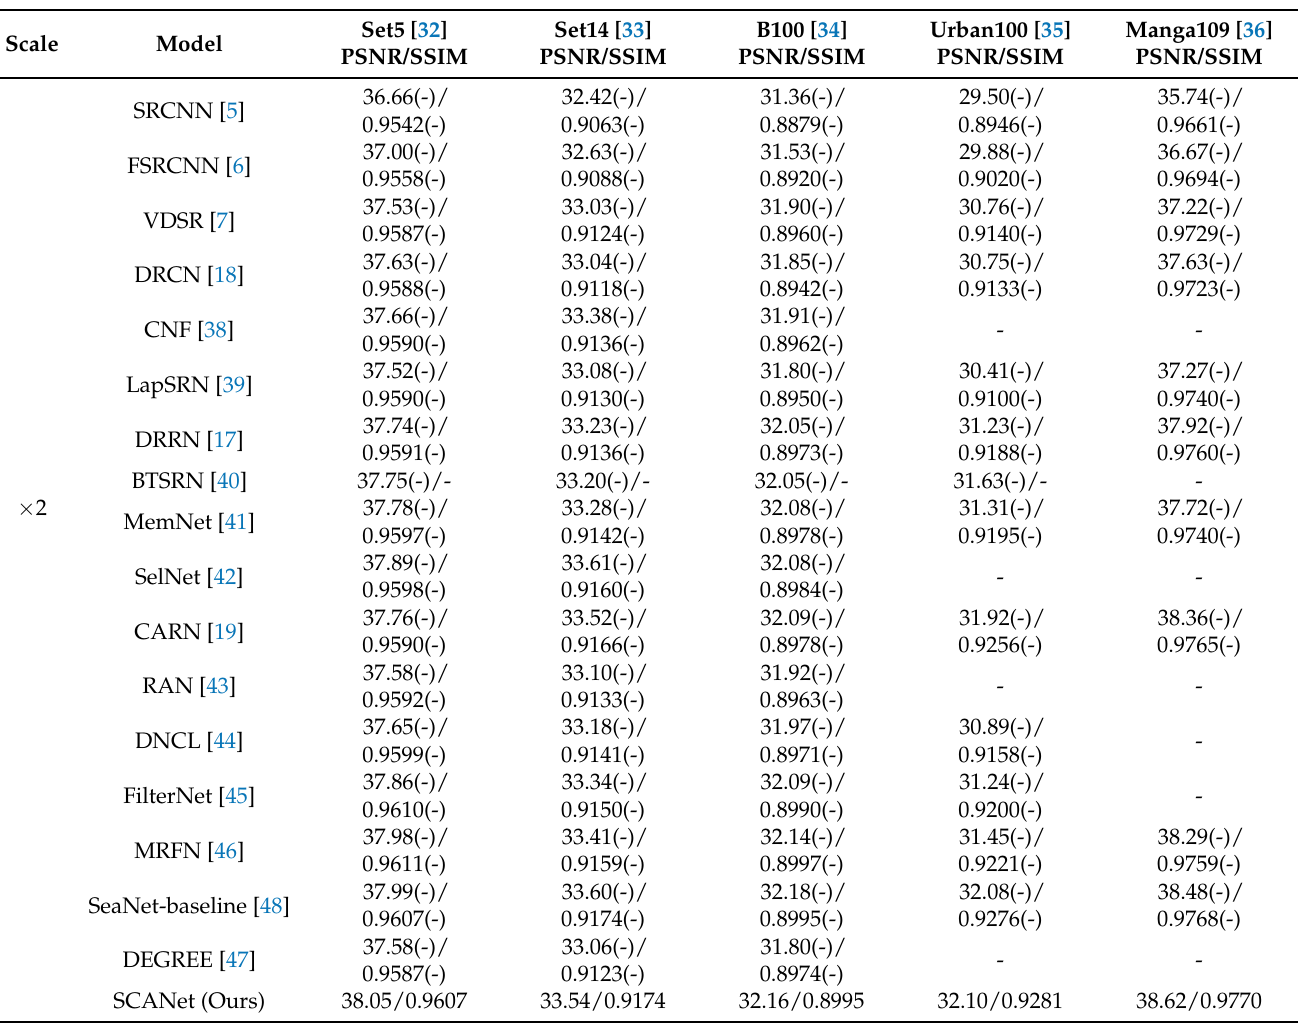
Table 2. Average PSNR/SSIM with degradation model BI × 2, × 3, and × 4 against five benchmarks. (+) means the result is better than our method, and (-) means the result is worse than our